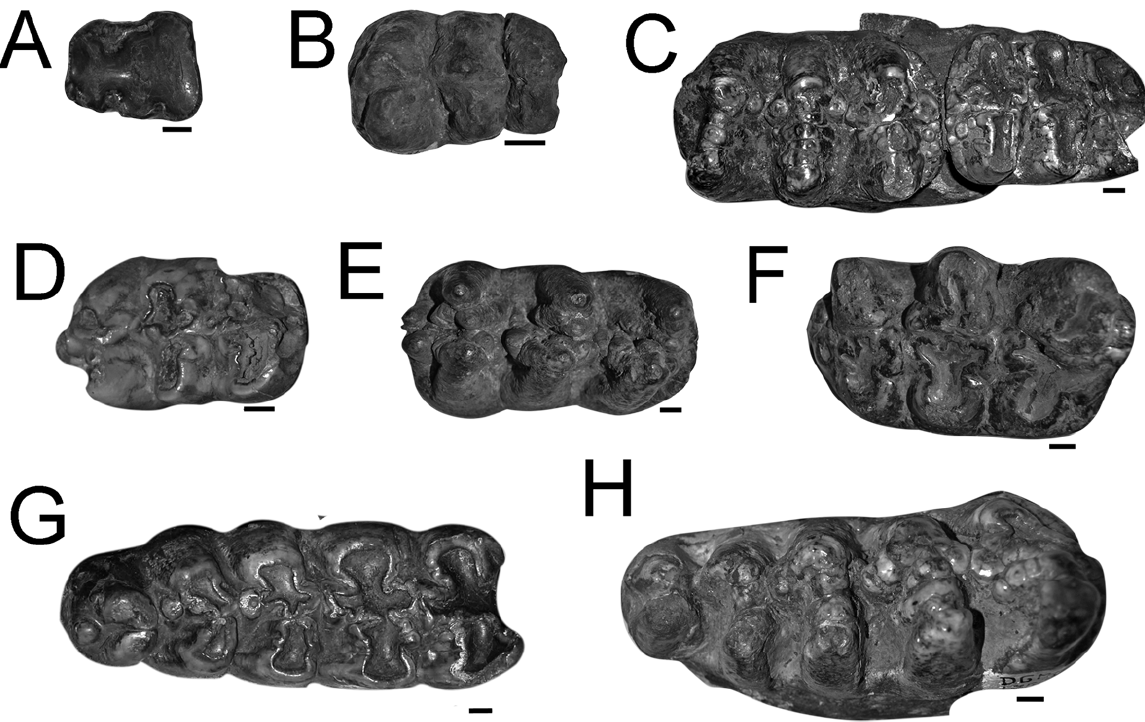
Fig. 3 – Molars of Stegomastodon waringi from the Quaternary of Águas de Araxá. A) Dp3: lower right molar in total wear (DGM 67M); B) Dp4: upper left molar without wear (DGM 752M); C) DP4 and M1: Upper right molars in wear stages 2 and 1 (DP4 at right and M1 at left, DGM 73M); D) m1: Lower left molar in wear stage 2 (DGM 141M); E) m2: Lower right molar without wear (DGM 75M); F) M2: Upper right molar in wear stage 2 (DGM 104M); G) m3: Lower left molar in wear stage 3 (DGM 133M); H) M3: Lower left molar in wear stage 2 (DGM